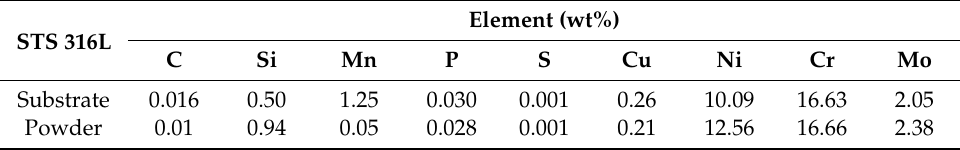
Figure 1. Schematic diagram of experimental setup for the laser metal deposition (LMD) process. Table 1. Chemical composition of STS 316L substrate and powder.